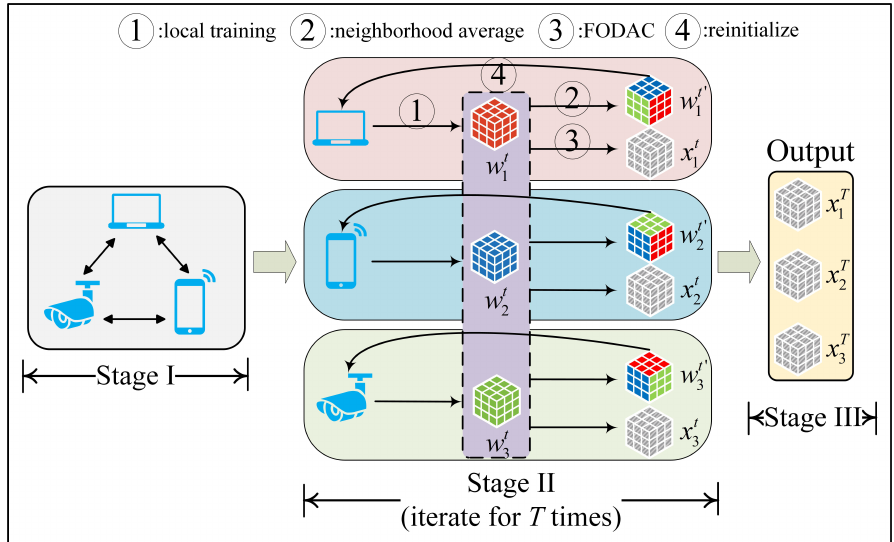
Figure 2. An overview of DACFL. Here a simple decentralized topology with 3 devices being pair- wisely connected is used as an example. Actually, the “neighborhood average” and “FODAC” in Stage II are carried out based on the models from a device’s neighbors, which contains not necessarily all models, but rely on a topology (not necessarily pair-wisely connected)